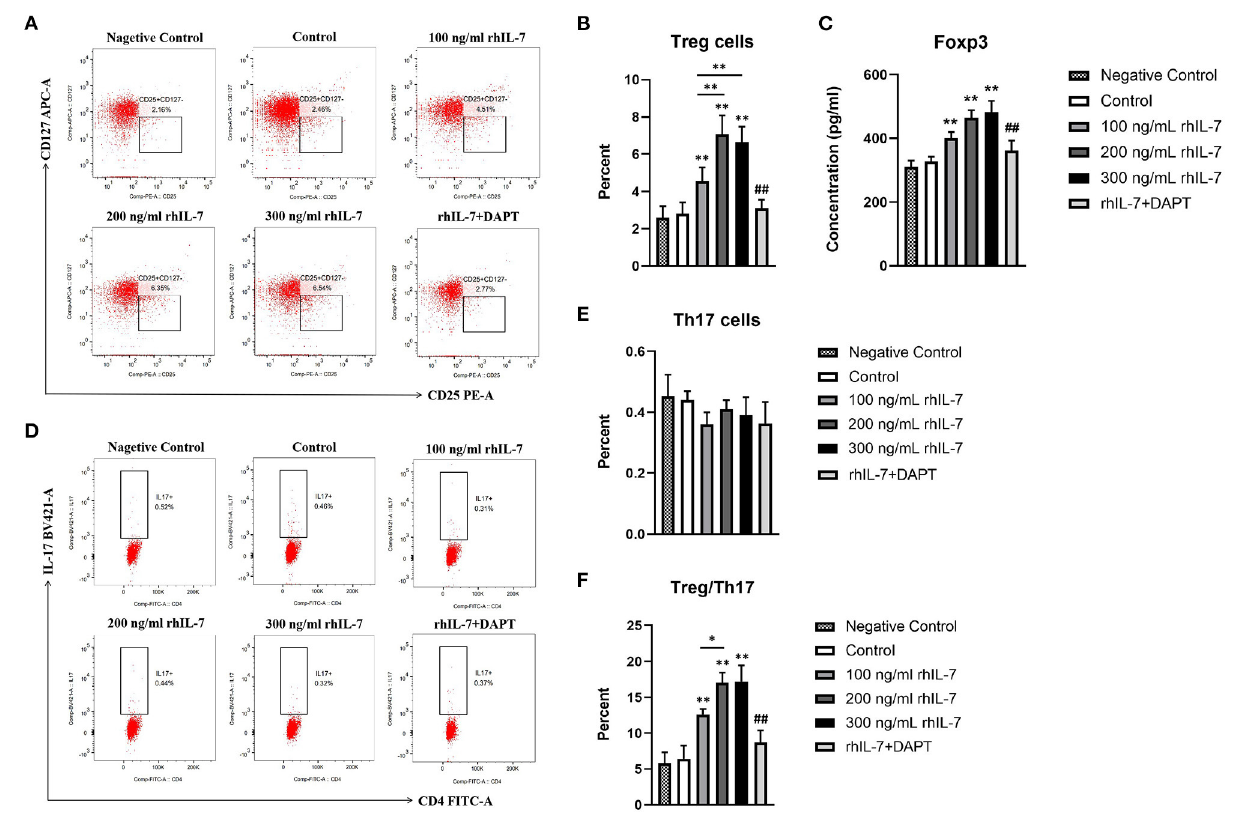
FIGURE 1 | Effects of conditioned medium of human periodontal ligament cells (hPDLCs) treated with rhIL-7 on the differentiation of Treg/Th17 cells. The supernatants of hPDLCs were collected after being treated with different concentrations of rhIL-7 for 24h and used to culture CD4 + T cells for 3 days. Flow cytometry (FCM) was used to detect the polarization of CD4 + T cells into Treg cells (A,B) and Th17 cells (D,E) . (C) The concentration of Foxp3 in CD4 + T cells was detected by ELISA. (F) The ratio of Treg/Th17. Representative dot plots show the gating strategy of FCM analysis. n = 3, * p < 0.05. ** p < 0.01. ## DAPT group compared with 200ng/mL rhIL-7 group, p <